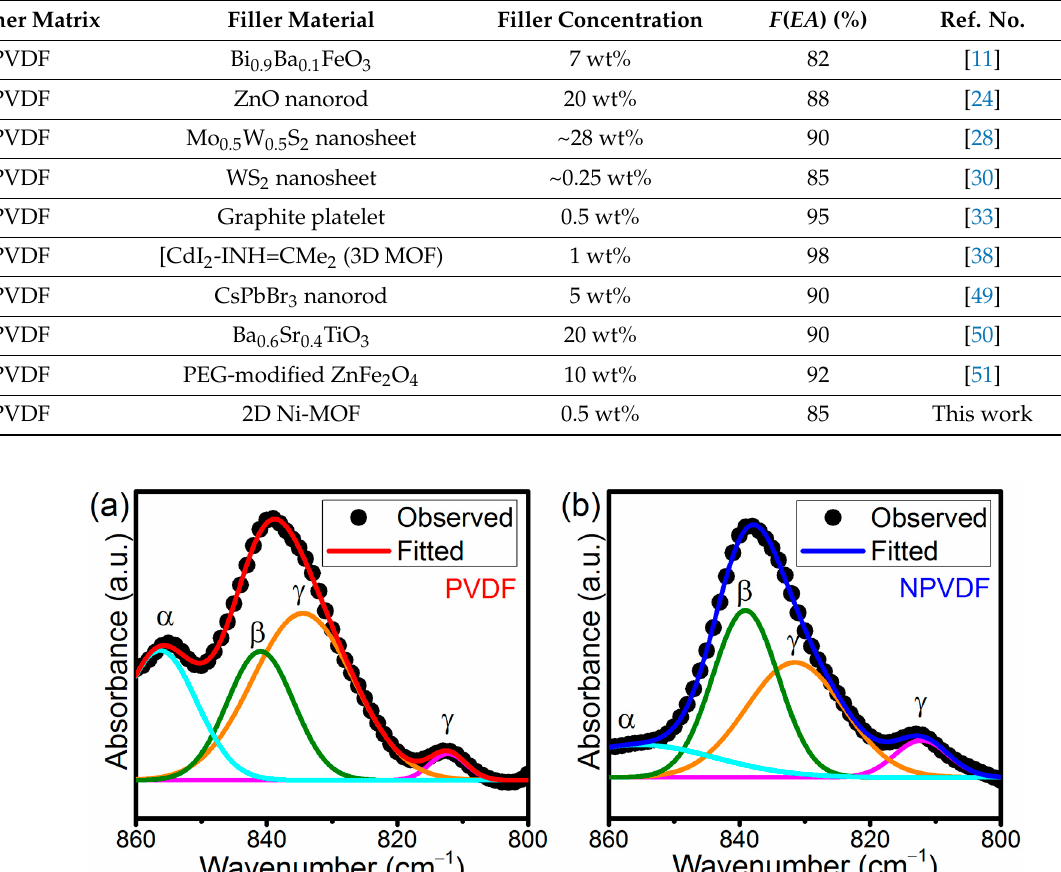
Table 2. Comparison of the amount of polar phase of NPVDF film with some other similar kinds of composites as reported earlier.